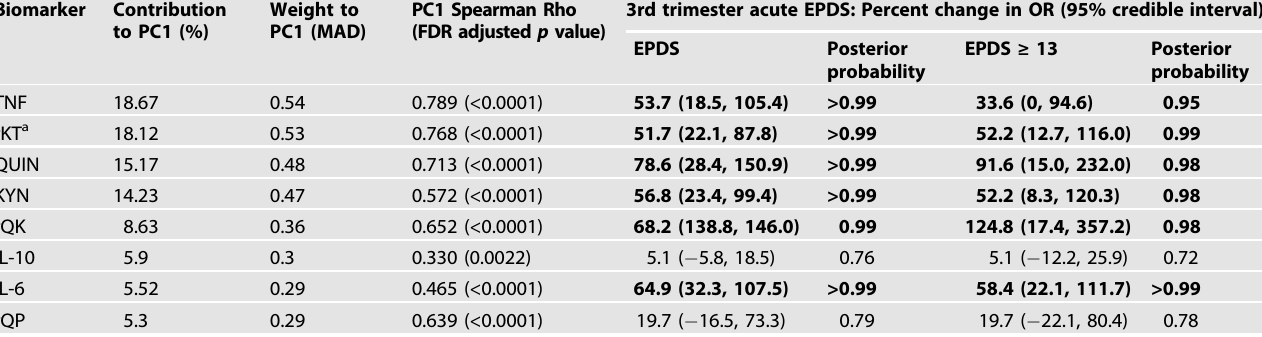
Table 2. Biomarker contribution to -and correlation with- PC1 during the 2nd trimester.